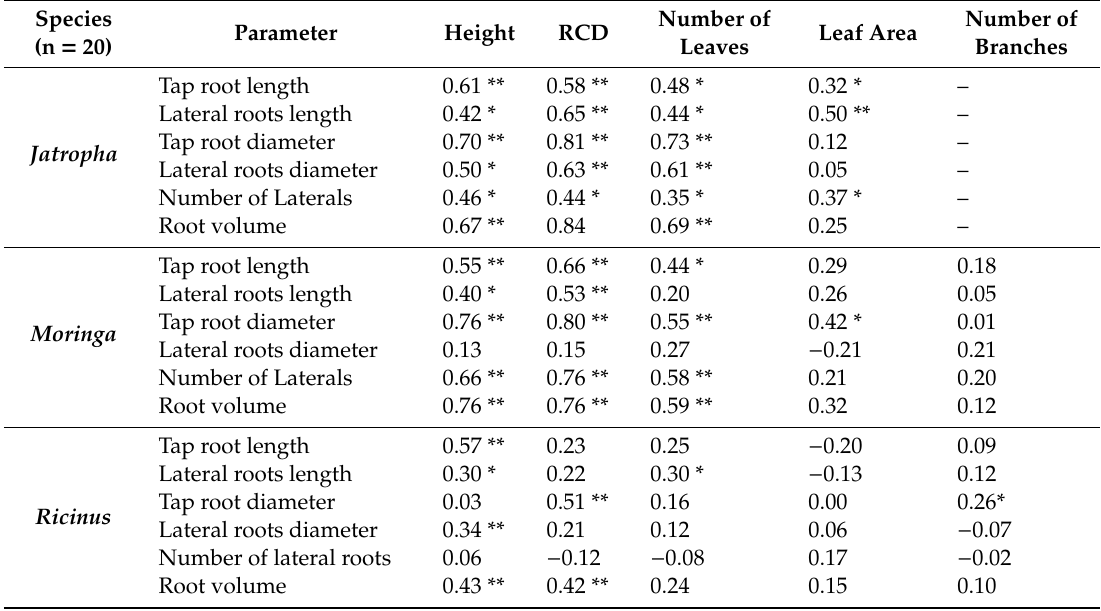
Table 7. Linear correlations between above- and belowground data of Jatropha curcas , Ricinus communis , and Moringa oleifera 83 days after root pruning and transplant.